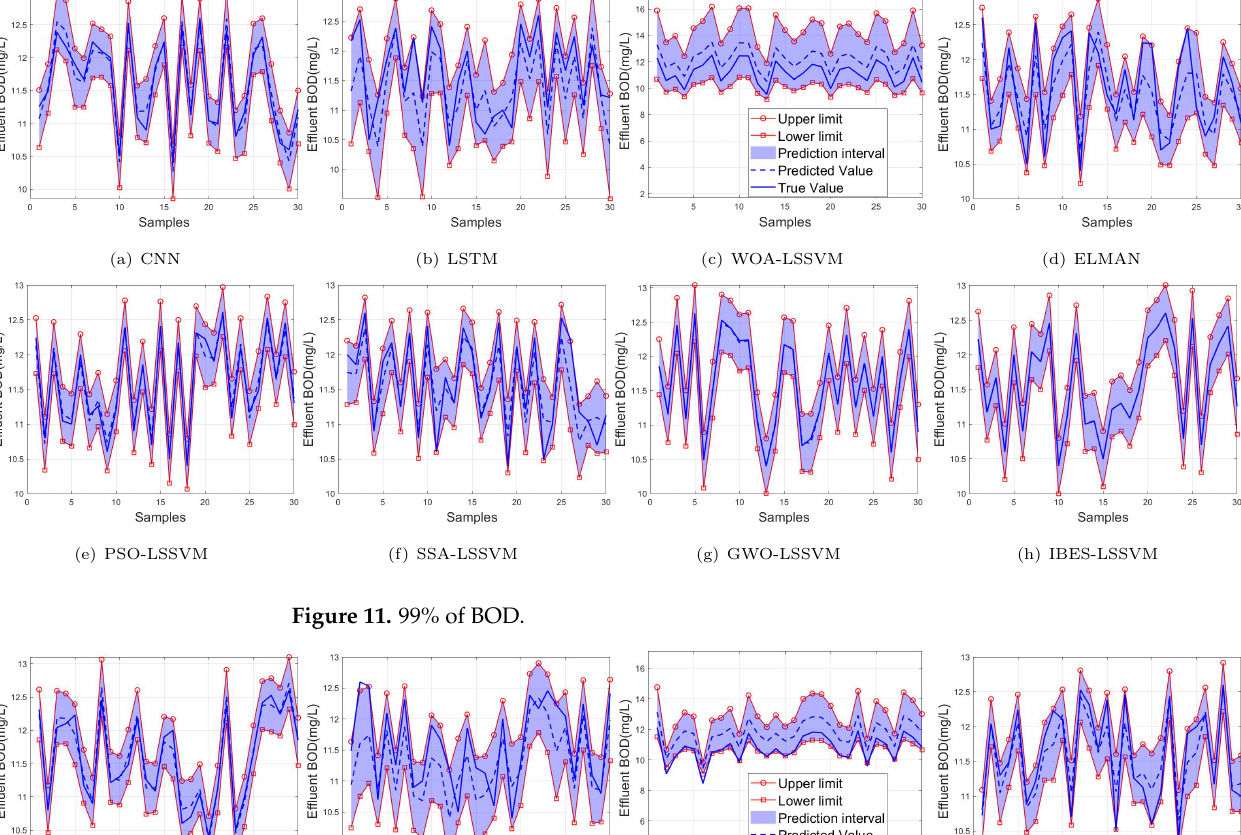
Figure 11. 99% of BOD.